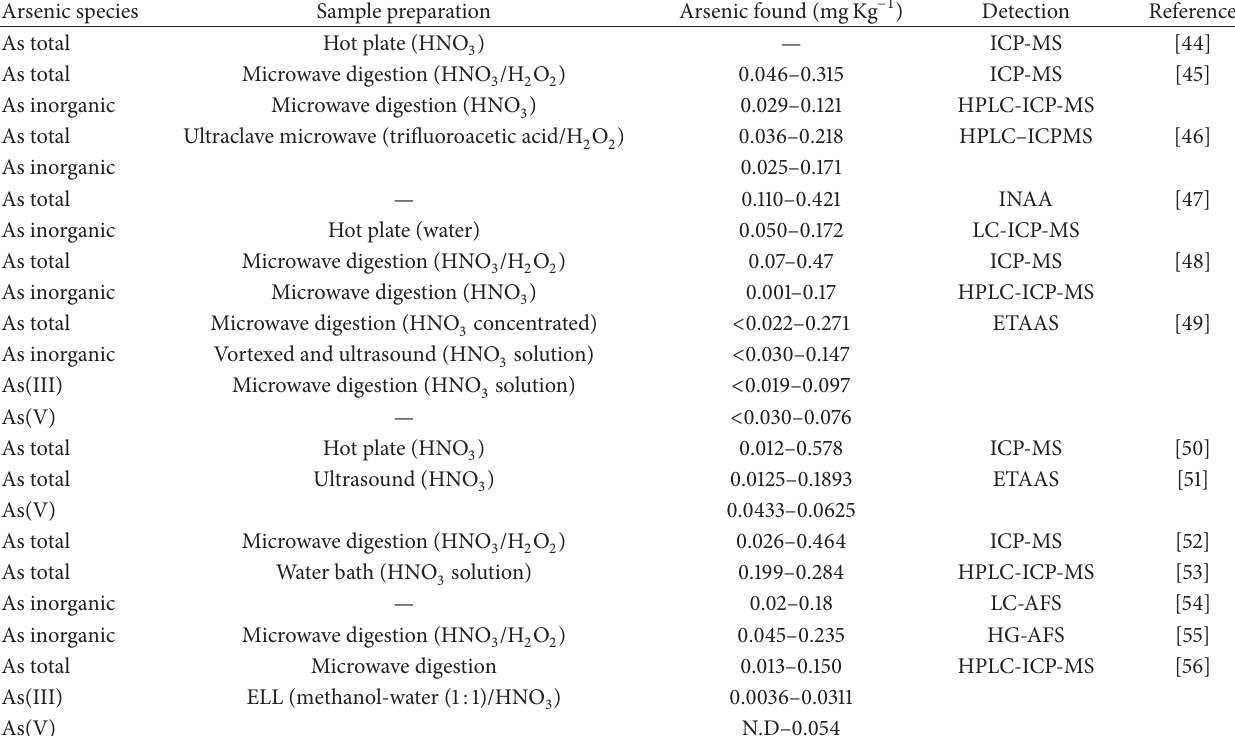
Table 1: Sample preparation methods for determination of inorganic arsenic in